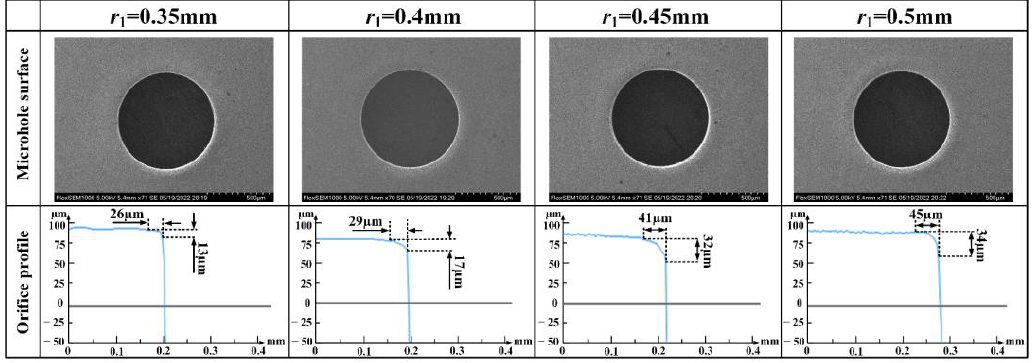
Figure 21. Influence of electrode radius on orifice chamfer.